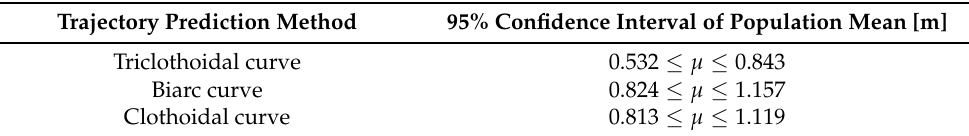
Table 1. Ninety-five percent confidence intervals of the population mean µ of the maximum absolute prediction error.